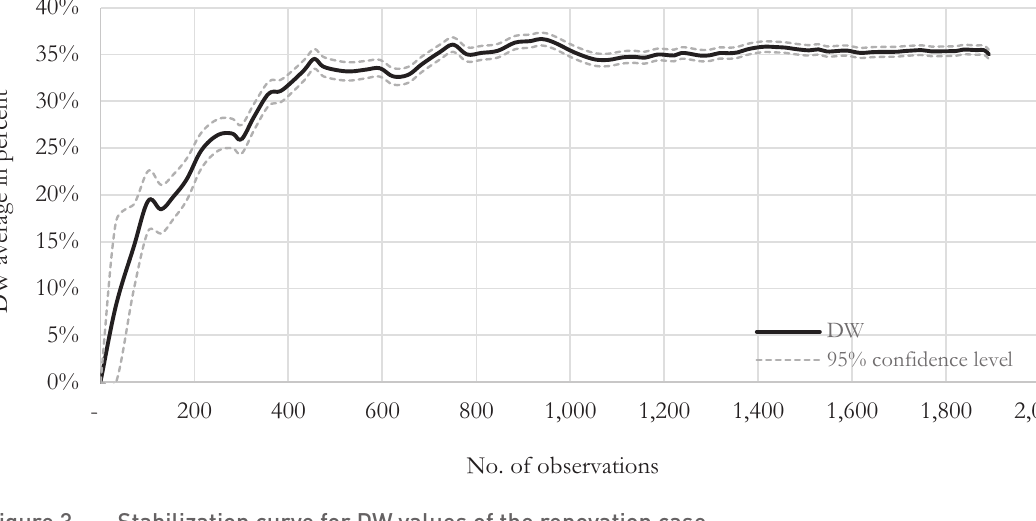
Figure 3. Stabilization curve for DW values of the renovation